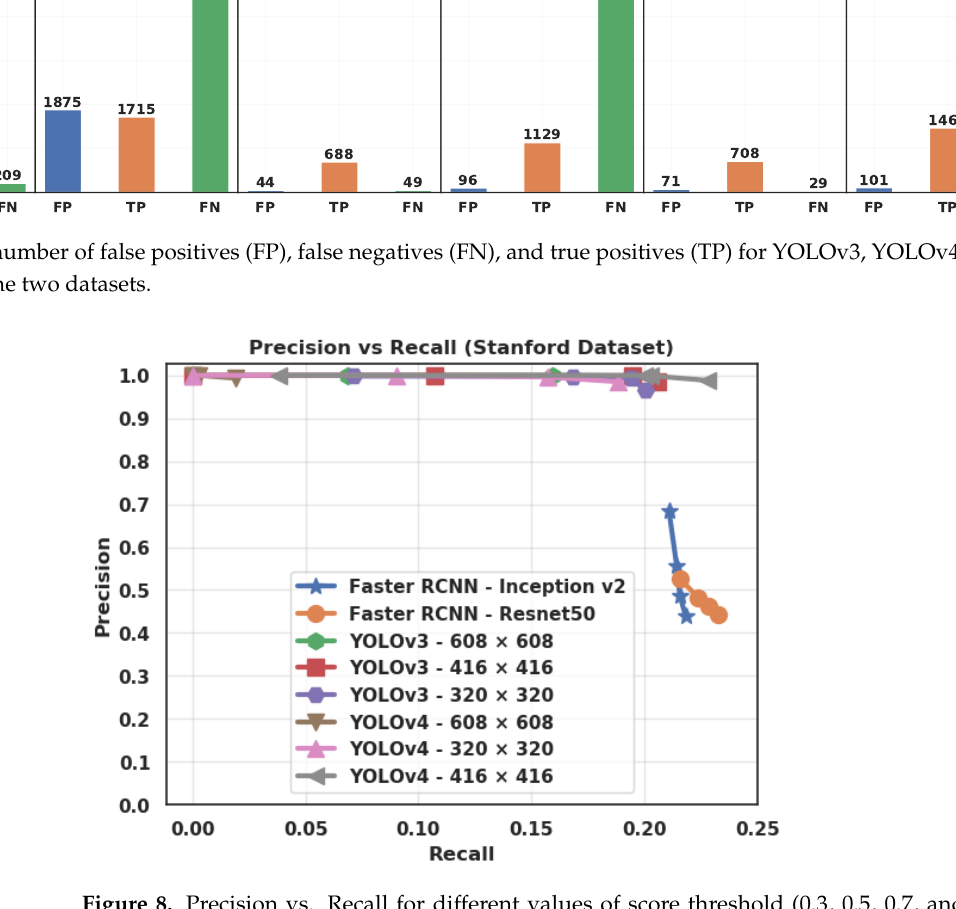
Figure 8. Precision vs. Recall for different values of score threshold (0.3, 0.5, 0.7, and 0.9), and IoU = 0.6 (Intersection over Union), on the Stanford